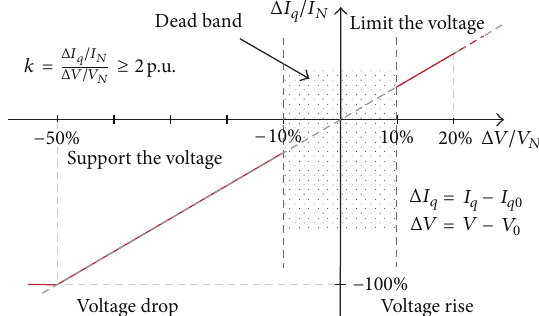
Figure 2: Voltage support requirement under grid faults for wind turbines